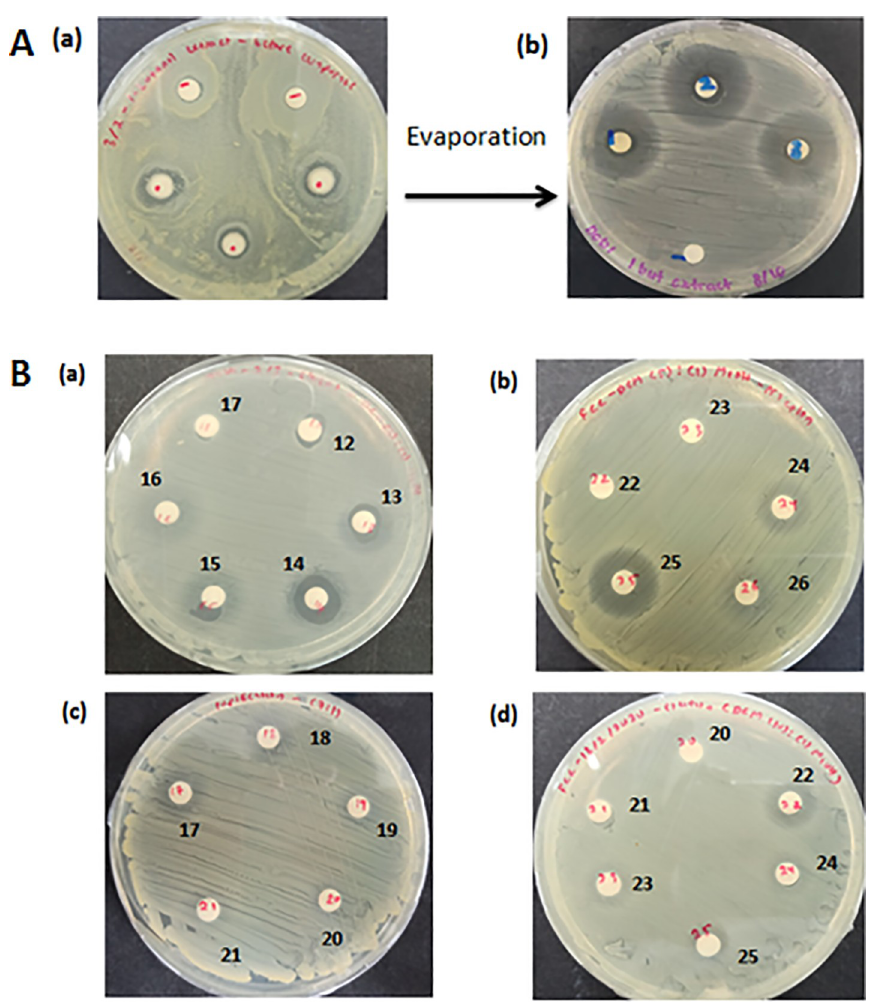
Fig 5. Antimicrobial activity of the 1-butanol extract and the silica gel purified product. (A) Antimicrobial activity of the 1-butanol extract observed (a) before and (b) after evaporation on MRSA ATCC 33742 lawn cell plate. The antimicrobial compound from the 24-h cell culture of strain PD9 was extracted using 1-butanol as the organic solvent. (B) Antimicrobial activity of the eluted fractions from different ratios of DCM: MeOH observed on MRSA ATCC 33742 lawn cell plate. (a) Active fractions from eluent with ratio DCM (3):(1) MeOH. (b) Active fractions from eluent with ratio DCM (5):(1) MeOH. (c) Active fractions from eluent with ratio DCM (7):(1) MeOH. (d) Active fractions from eluent with ratio DCM (10):(1)